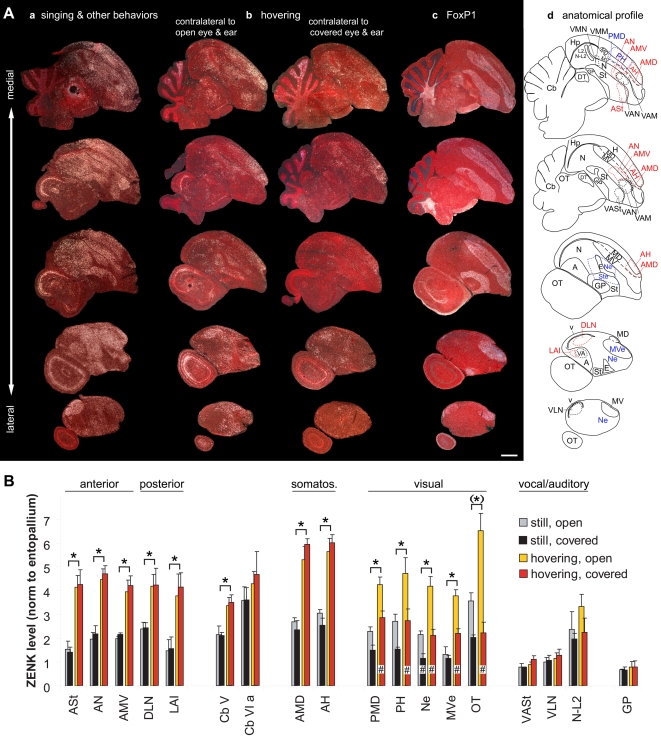
Movement-induced ZENK expression in male Anna's hummingbird.A. Serial sagittal sections of: (a) Vocal and other areas: ZENK expression in a bird that was singing interspersed with flying near an outdoor feeder in the morning (high expression in non-vocal areas is due to other behaviors, including flying and feeding); (b) Auditory, visual, and movement-associated areas: ZENK expression in control hemisphere (contralateral to open eye and ear) and experimental hemisphere (contralateral to covered eye and ear) of a bird hovering in a plexiglass cage in dim light; (c) FoxP1 expression from adjacent sections of the experimental hemisphere of the bird in (b); (d) Corresponding anatomical drawings; red: areas with movement-induced expression; blue: areas with visual- or auditory-induced expression (auditory areas also determined from a previous study [7]). First row are medial-most sections. Anterior is right, dorsal is up. Scale bar, 2 mm. Compare with coronal sections in figure S7. B. Quantification of ZENK expression levels in 18 different brain regions, in both hemispheres, in two groups of hummingbirds. * indicates brain areas with statistically significant increases in both experimental (covered) and control (open) hemispheres of hovering birds relative to the experimental and control hemispheres of the relatively still birds (p<0.05, one-tailed t-test, n = 3 relatively still and 4 hovering animals for both hemispheres). # indicates significantly less increase in the experimental hemisphere (p<0.05, paired t-test on experimental and control hemispheres within birds). The (*) for the OT indicates that this is the only visual area that did not show increased ZENK expression in the experimental hemisphere opposite the covered eye. Error bars, S.E.M.